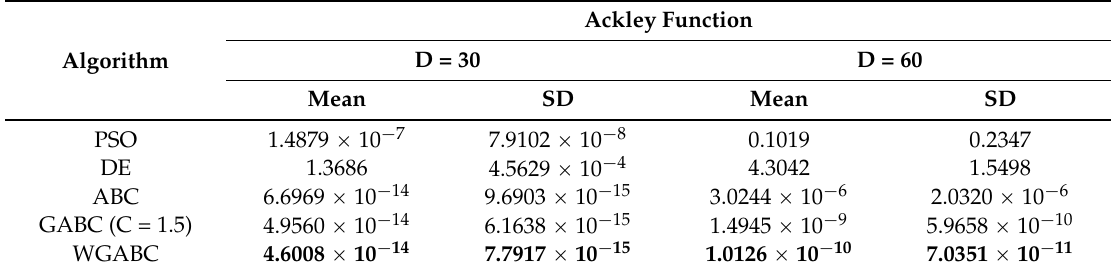
Table 6. The mean and standard deviation of the Ackley function on the different algorithms.